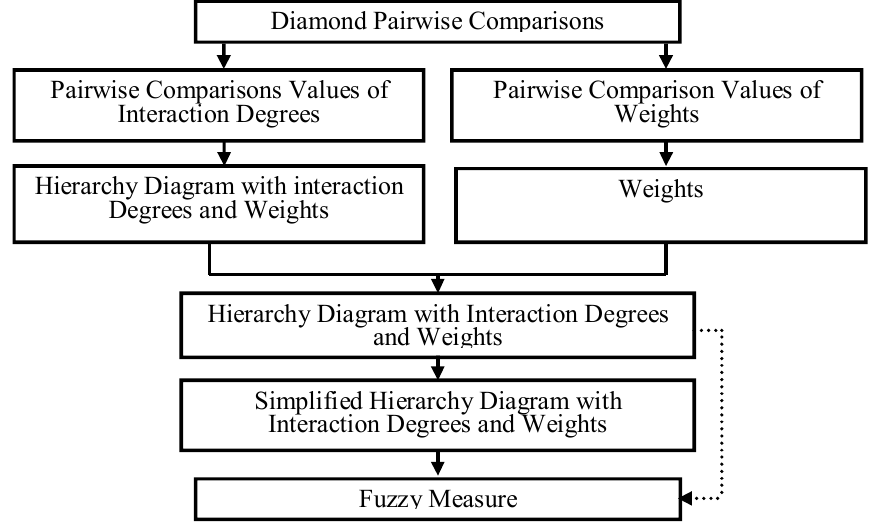
 transformation. Fig. 4 outlines the s Pairwise Comparison Values of Weights Weights Hierarchy Diagram with interaction